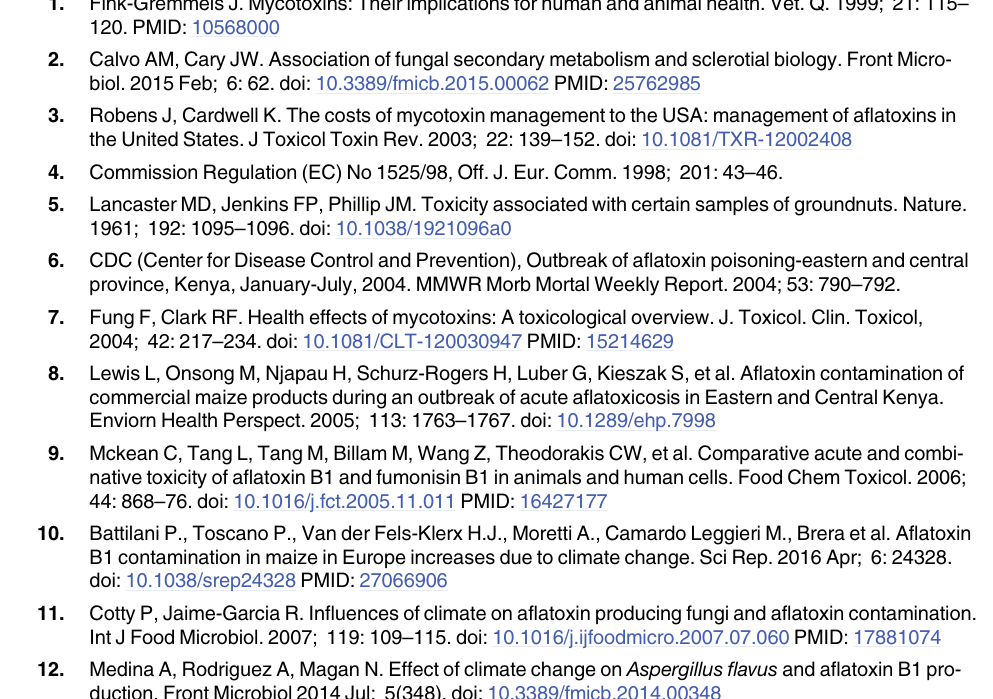
S5 Fig. Effect of rmtA on sclerotial production on Wickerham medium. A . flavus wild type (WT), Δ rmtA , complementation (com) and OE rmtA (OE) strains were point-inoculated on Wickerham medium and incubated for 7 days (A) and 17 days (B) at 30°C. Plates were then sprayed with ethanol and micrographs of sclerotia were obtained approximately 1.5 cm from the center at 12.5X magnification using a Leica MZ75 dissecting microscope. (PDF) S1 Table. Primers used in this study. S2 Table. Sequence comparison of RmtA in other fungal species. S3 Table. Sequence Comparison of RmtA in eukaryotic model